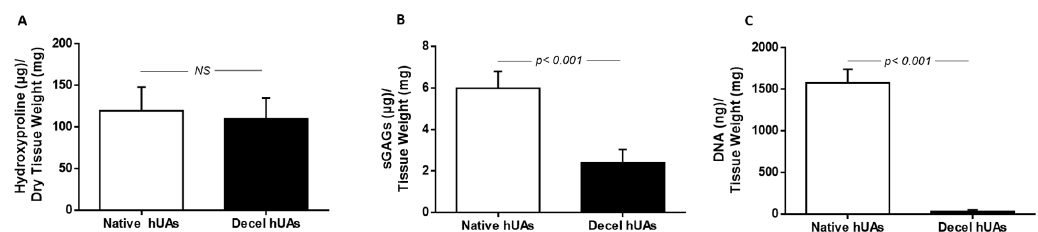
Figure 4. Biochemical and DNA content evaluation of hUAs before and after the decellularization process. Total hydroxyproline content (representing collagen content), sGAGs content, and DNA quantification of native and decellularized hUA ( A – C ), respectively. Statistically significant differences were observed in the sGAGs ( p < 0.001) and DNA ( p < 0.001) content between native and decellularized hUAs.